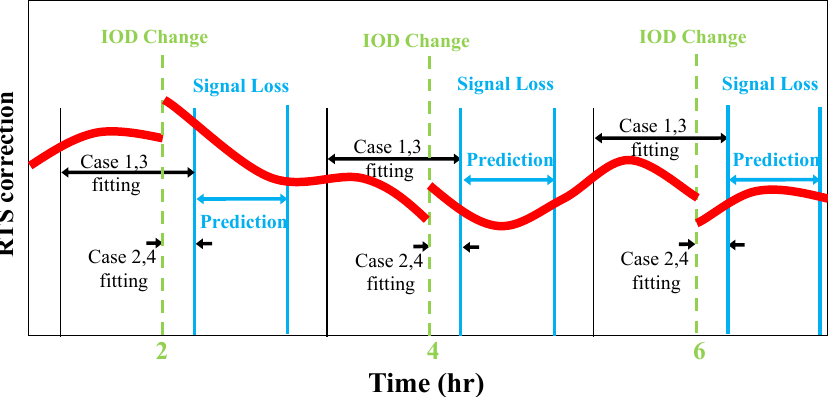
Figure 8. Time intervals of the LSTM and polynomial update and prediction.